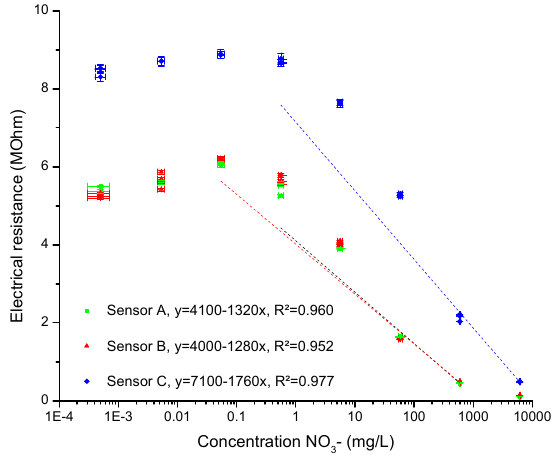
Figure 3. Electrochemical sensor calibration curves using KNO 3 solutions. Each sensor presents a fitting that covers the linear portion of the signal and that is assigned by